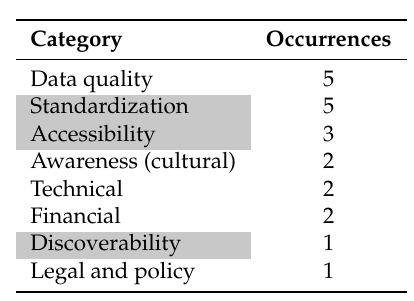
Table 4. The highlighted rows correspond to data users’ barriers mentioned in the literature. The remaining rows were barriers mentioned as data producers’